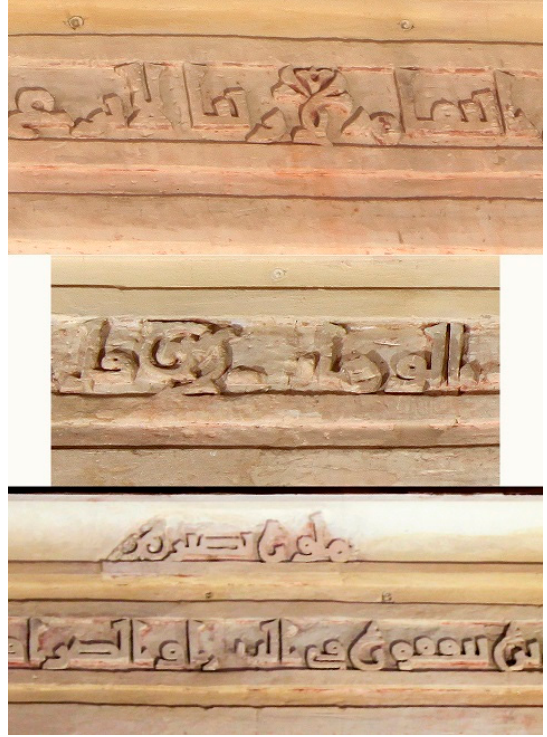
Figure 15. Great Mosque of Cordoba. Details of the Kufic inscription at the top of the wall in the axial nave. © Photos took by author.